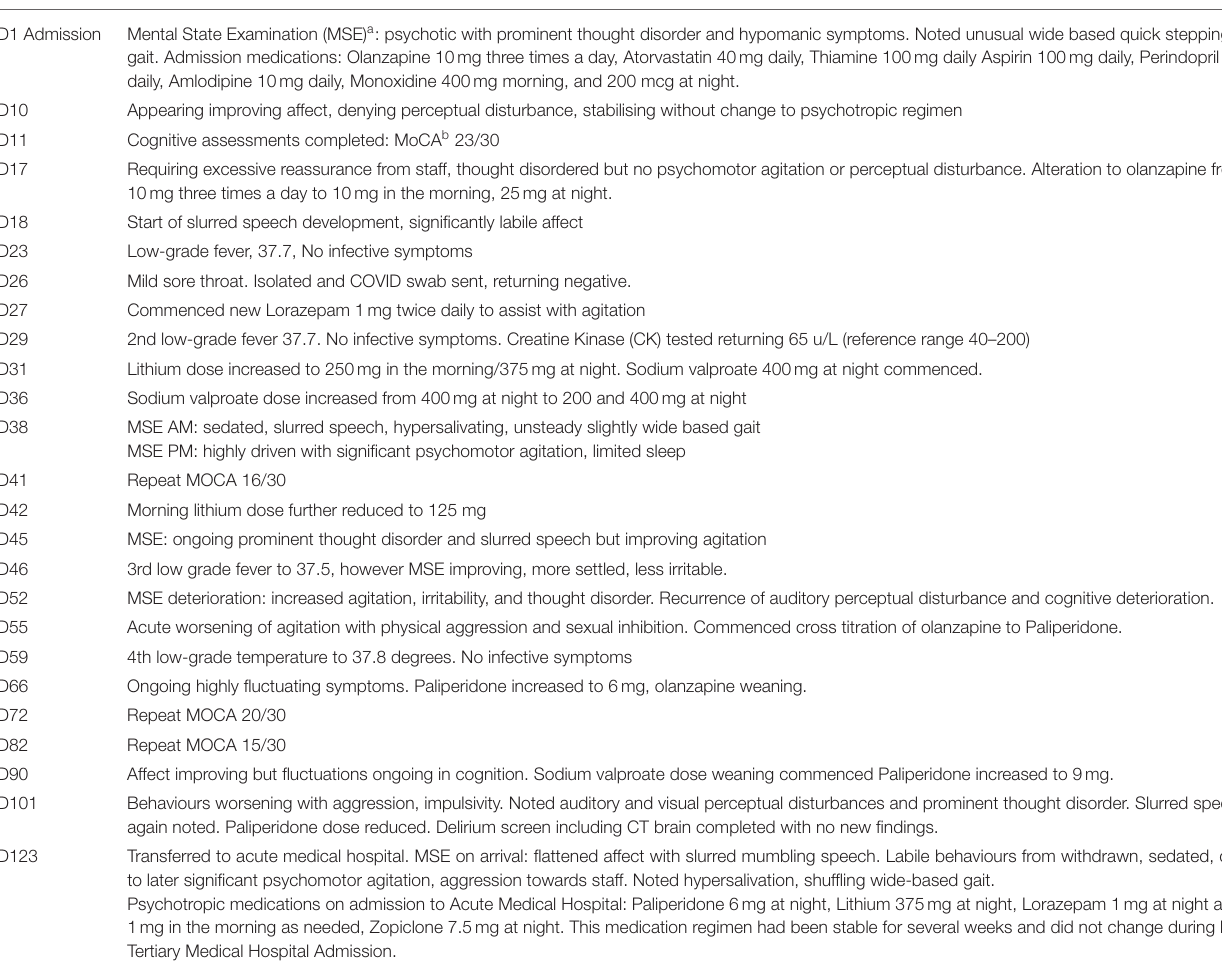
TABLE 1 | Inpatient unit (IPU) admission